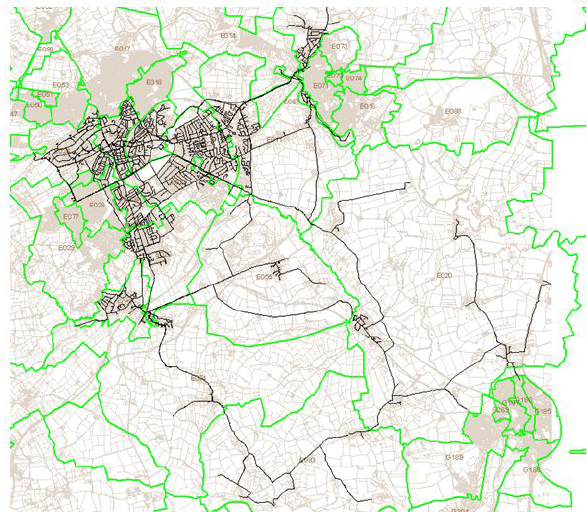
Figure 1. Online model geographical extent showing all pipes, background map and DMA